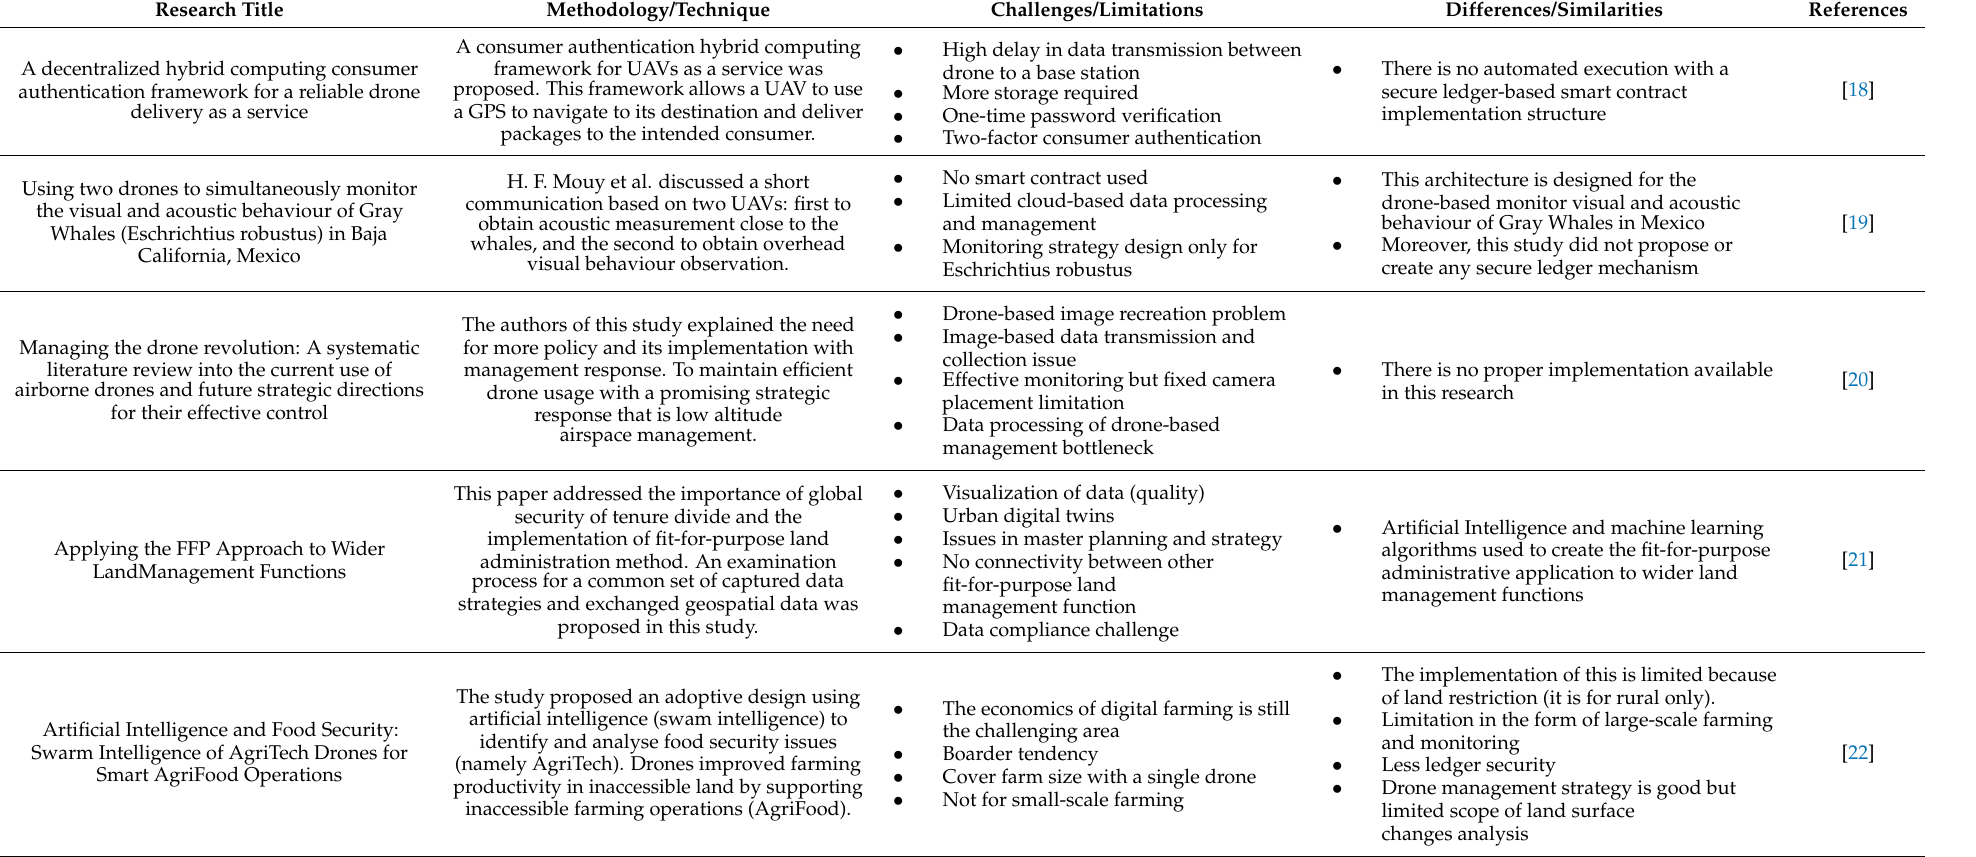
Table 1. Land Surface Changes and Fog-Cloud Computing-Related